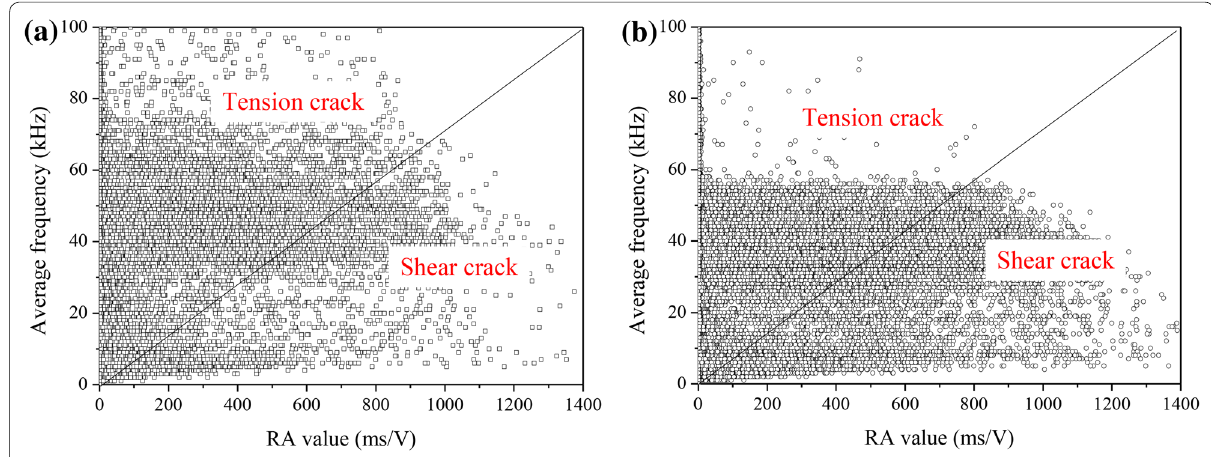
Fig. 16 Relation between RA value and average frequency under monotonic loading. a Plain concrete; b